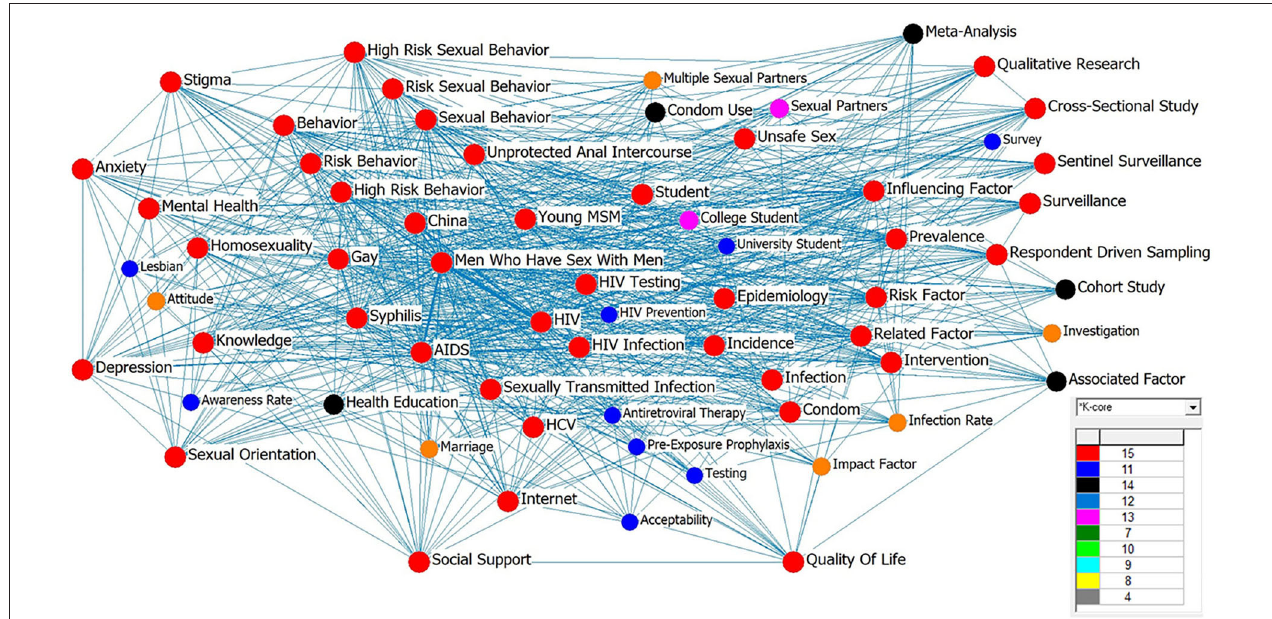
FIGURE 4 | Co-word analysis of all English (EN) keywords and translation of Chinese ones. The colors and lines were automatically generated after K-core analysis, specifically, the larger the number corresponding to the color, the higher the frequency of co-occurrence; the thicker the line, the stronger the degree of co-occurrence.